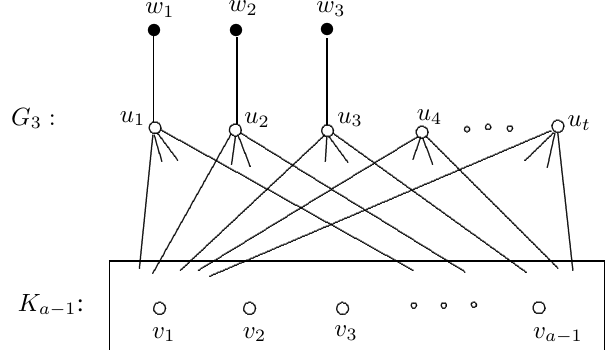
Figure 5: The graph G